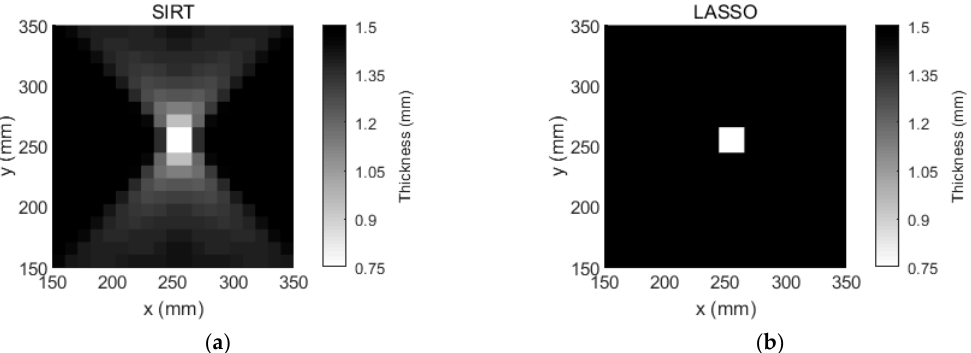
Figure 13. Tomographic reconstruction images for a 1.5 mm thick aluminum plate with a 20 mm diameter circular flat-bottomed hole. Thickness loss was 50% within the flaw. ( a ) The tomographic reconstruction image using the SIRT, and M = 20, ( b ) The tomographic reconstruction image using our method, and M = 5.